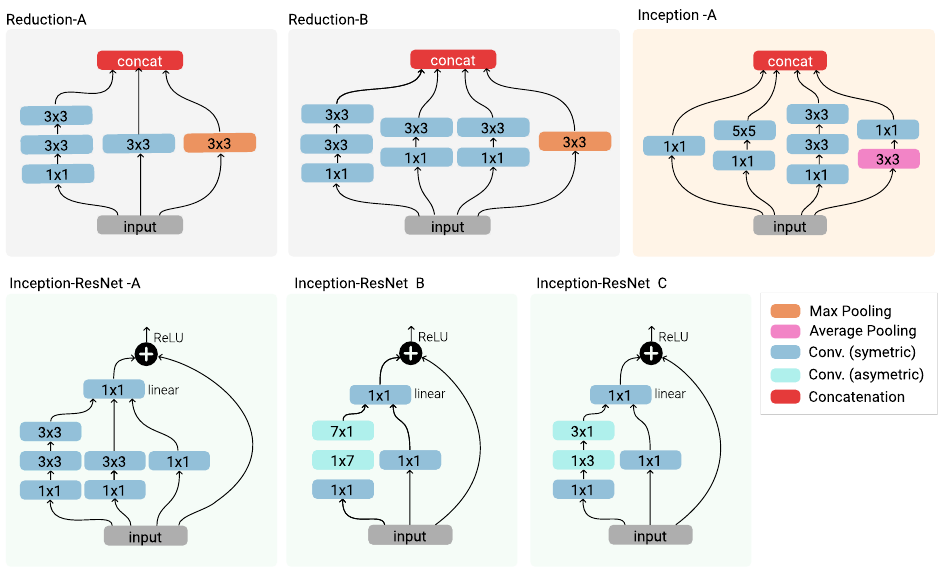
Figure 8. Inception-ResNetV2 modules.